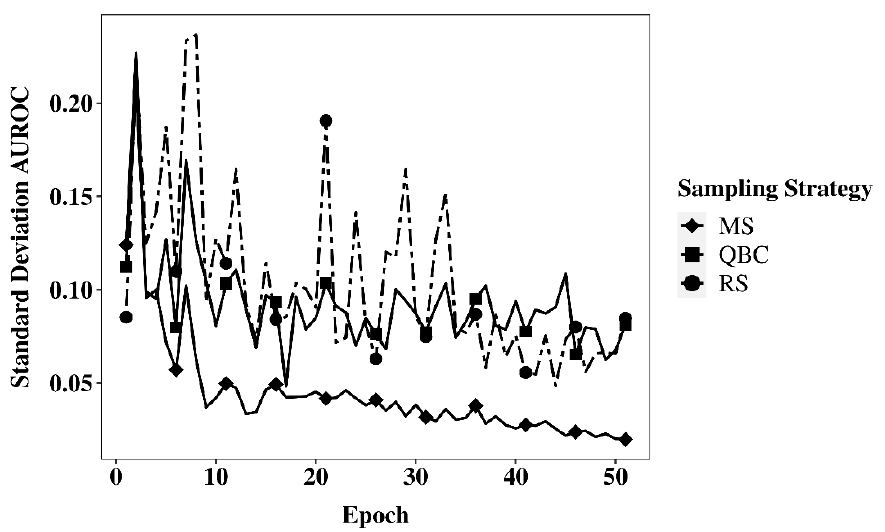
Figure 4. Standard deviation of AUROC estimates across all 150 repetitions for different sampling methods in the target area.